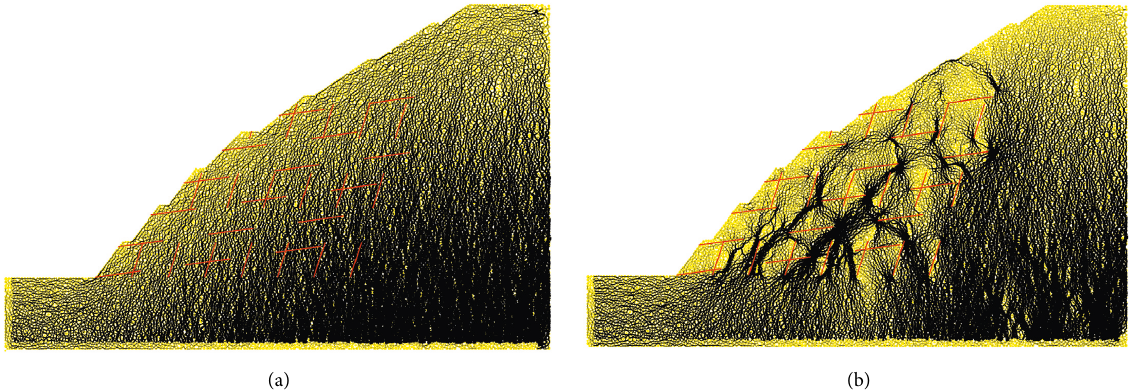
Figure 10: Contact force chain diagram: (a) 0 time step and (b) 25,000 time steps.